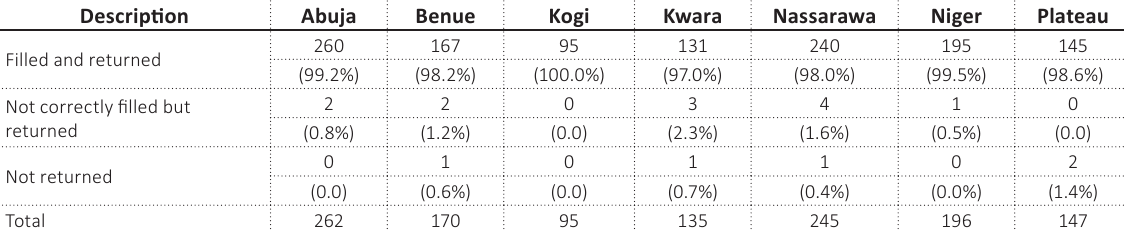
Table 4. Administration of instrument